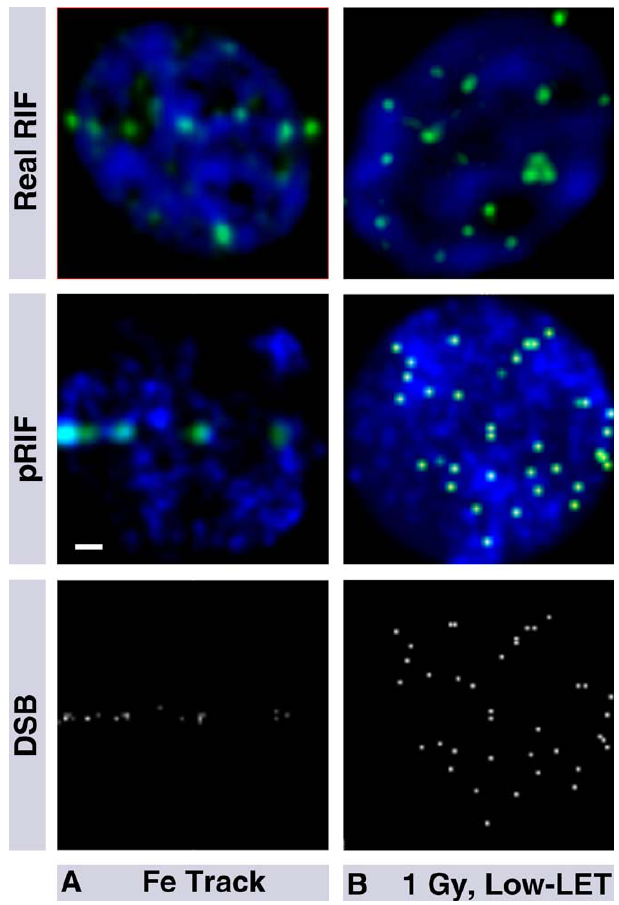
Figure 1. Comparison between Simulated and Experimental Images for Different Types of Radiation (A) Shows RIF within a nucleus traversed by high energy Fe ions (1 GeV/ amu Fe). (B) shows a nucleus exposed to photons. Shown at the top are RIF images of nuclei taken from a microscope (DAPI in blue and DNA damage marker c H2AX in green) 5–10 min post-IR. Middle images are pRIF microscopic images at the same magnification. These pRIF images are generated by blurring DNA damage simulations for equivalent doses of radiation with the PSF of the optic used. For pRIFs, the blue channel shows the resulting nuclear density and the green channel shows DSB. If the PSF is omitted from the simulation, DSB locations can be better resolved, as shown in the gray images at the bottom of each panel (brightness proportional to the number of breaks within each pixel). Scaling bar shown in white is 1 l m wide.